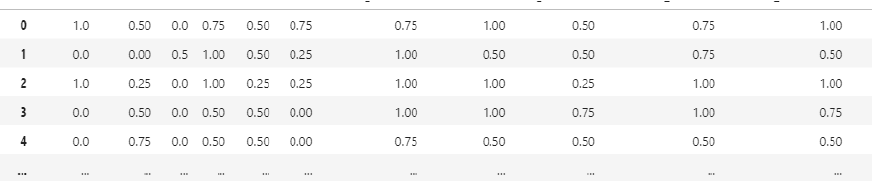
Figure 2. Online after